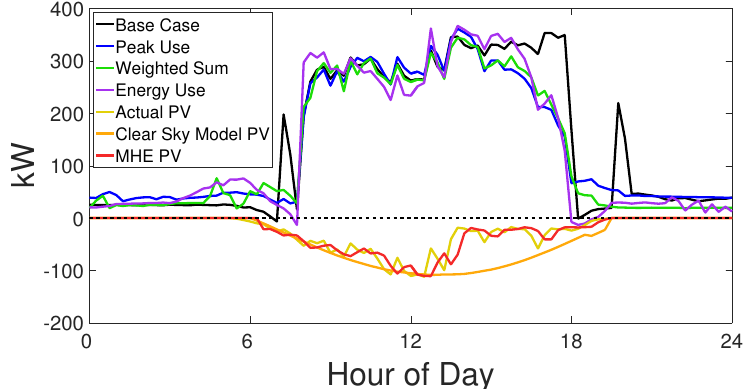
Figure 12. A comparison between the total building load profiles obtained under the rules-based control scheme (black line), the Peak Demand MPC (blue line), the Net Energy Use MPC (purple line), the Weighted Sum MPC (green line), all with a fifteen-minute moving horizon solar forecast and a five-hour MPC horizon for the “low solar" day. The actual solar power availability is shown by the yellow profile; the clear sky model’s predicted solar power by the orange profile, and the estimated solar availability based on the moving horizon estimation scheme by the red